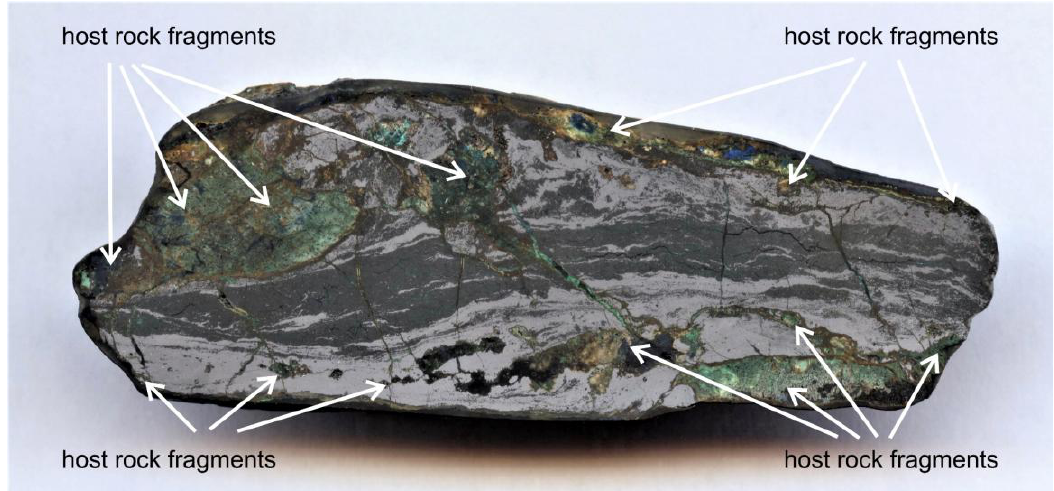
Figure 1. Dispersed-light dark field image of Se-vein Type-4 (2.2-cm-thick, 6.6-cm-wide, embedded in resin, surface rolling grinded, with 1.200 mesh SiC abrasive), with layers and lenses of klockmannite (dark grey) and clausthalite (light grey) forming a strongly foliated and folded mélange (cf. Section 3.2.1). The spotty and lens-like aggregates of the trachytic host rock fragments are partly rotated; the vein selvage, host rock fragments and diagonal fractures are stained by various alteration products, such as goethite (dark brown), azurite and chalcomenite (blue), and malachite (green).